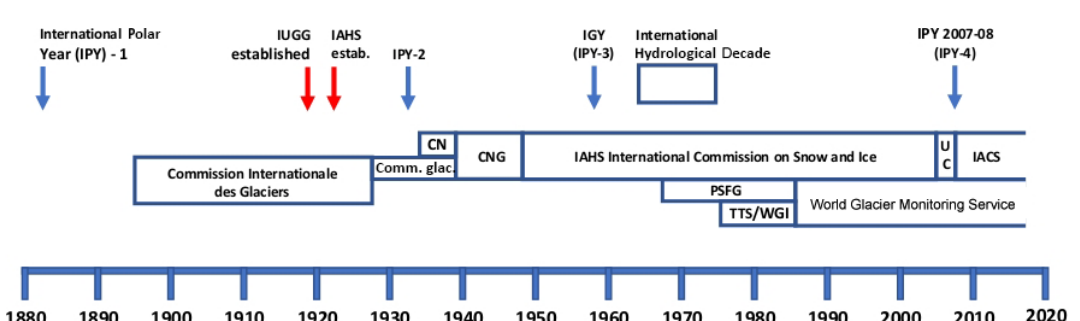
Figure 1. Schematic timeline showing the progression from the Commission Internationale des Glaciers (CIG) to the IUGG International Association of Cryospheric Sciences (IACS). This distinguishes two equally important heritage lines: monitoring glacier fluctuations and their link to climate (bottom) and cryospheric science more broadly (top). It also shows other major scientific programs and events relevant to the progression. (CN = IASH Commission des Neiges; Comm. Glac. = IASH Commission des Glaciers; CNG = IASH Commission des Neiges et des Glaciers; UC = IUGG Union Commission for the Cryospheric Sciences; PSFG = Permanent Service on the Fluctuations of Glaciers; TTS/WGI = Temporary Technical Secretariat for the World Glacier